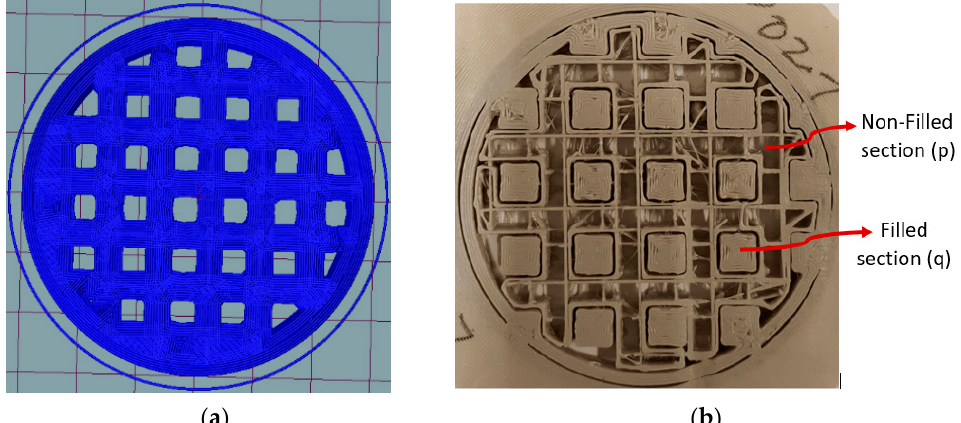
Figure 4. X-sectional views of test specimen with ( a ) complete lattice structure within the shell ( b ) internal structure of the hollow bar.